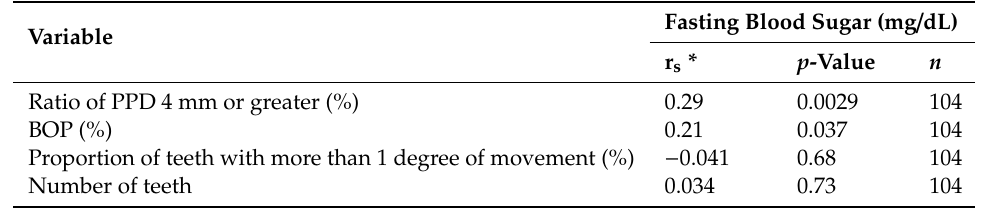
Table 5. Correlations among fasting blood sugar, the PPD ratio (4 mm or greater), and BOP. Fasting Blood Sugar (mg / dL) Variable r s * p -Value n Ratio of PPD 4 mm or greater (%) 0.29 0.0029 104 BOP (%) 0.21 0.037 104 Proportion of teeth with more than 1 degree of movement (%) − 0.041 0.68 104 Number of teeth 0.034 0.73